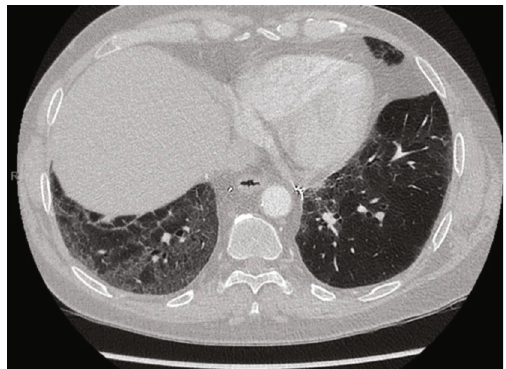
Figure 3: CT chest imaging 2 years (12/09/2018)